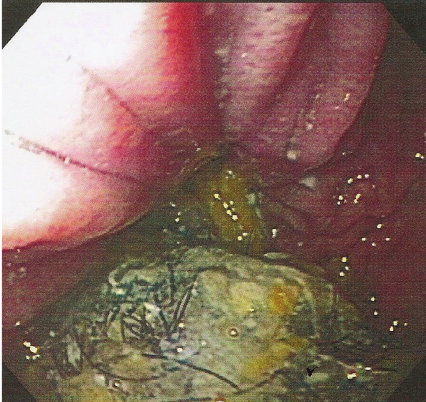
Figure 3: Endoscopic image of the gastric trichobezoar (greenish mass with dark strands of hair at the bottom of the image).